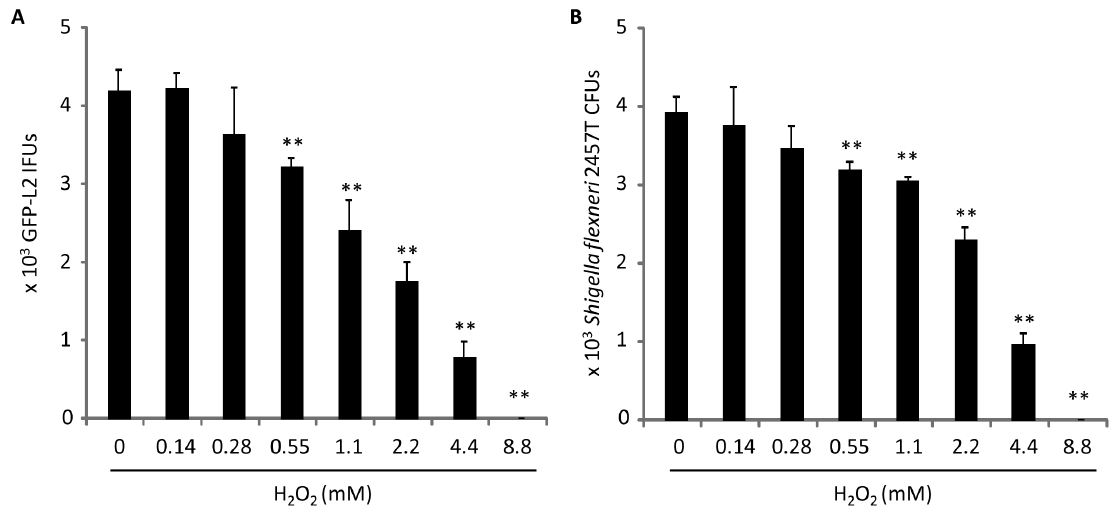
Figure 7. Dose-dependent killing of Chlamydia (A) and Shigellaflexneri (B) by exogenous H 2 O 2 . GFP-L2 or S. flexneri 2457T was diluted in MRS containing indicated concentrations of H 2 O 2 . Following 1 h incubation at room temperature, remaining H 2 O 2 was removed by catalase. Surviving EBs were quantitated as in Fig. 1; surviving 2457T bacteria were quantified by scoring colony-forming units (CFU) on LB Agar plates inoculated with serially diluted bacterial suspension. Values were averages 6 standard deviations of triplicate experiments. Single and double asterisks signify statistically decreased live bacteria in MRS with an indicated concentration of H 2 O 2 , as compared to control non-supplemented MRS (P , 0.05 and P , 0.01, respectively).